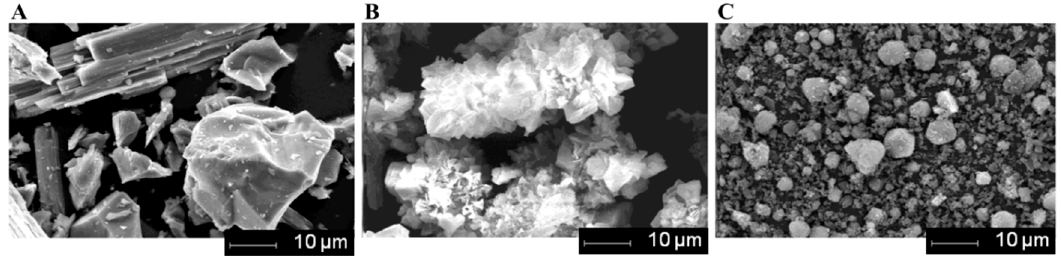
Figure 4. Comparison of particle morphology of original ( A ); stirred carbonated ( B ); and sonicated carbonated ( C ) CC slag powders [22]. Re-used with permission from Elsevier (4366260475887).